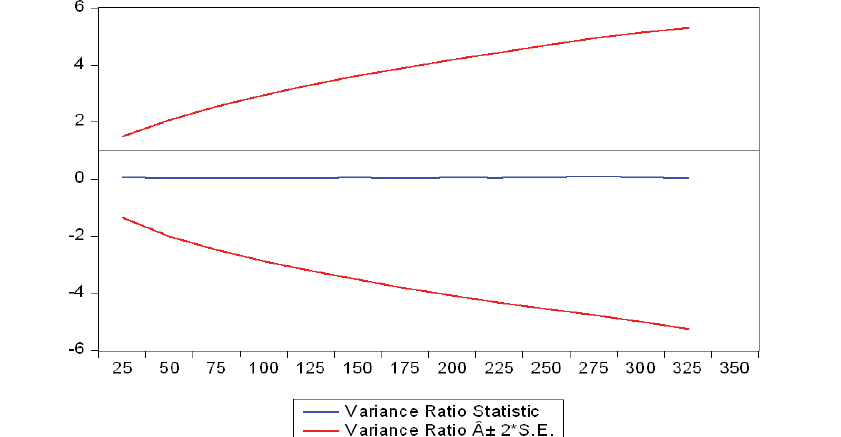
Fig. 4. Graphical illustration of the efficiency of the DSE share index weekly data over the test periods (January 2009 to August